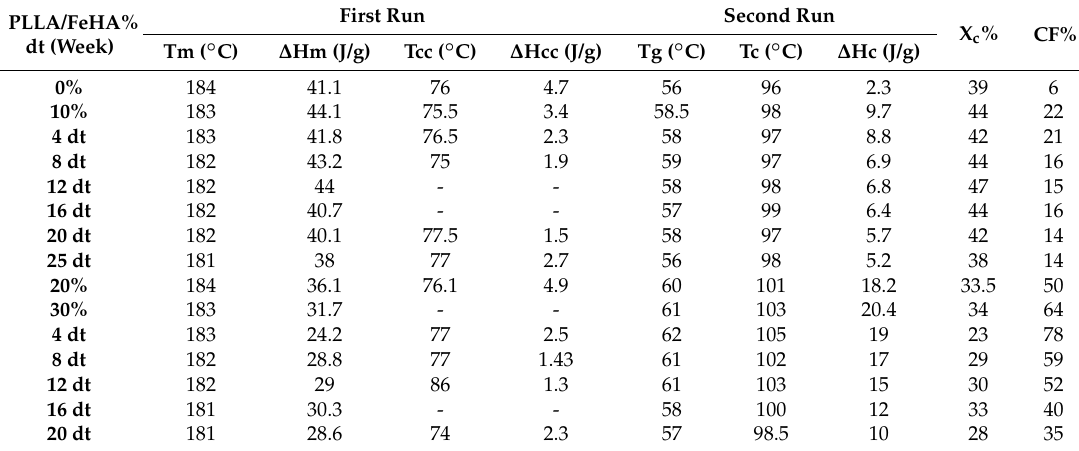
Table 2. Parameters obtained by thermal analysis on the PLLA-FeHA system: dt (weeks) = degradation time in weeks, Tm = melting point ( ◦ C), ∆ Hm = melting enthalpy (kJ/kg), Tg = glass